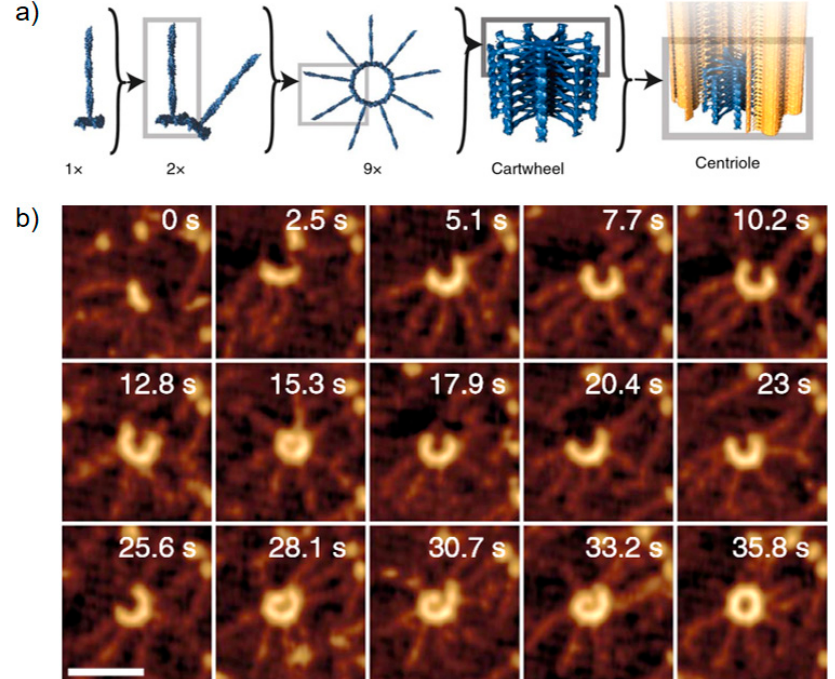
Figure 5. High-speed AFM imaging of biological systems using FEBID modified Si tips. ( a ) Formation process of cartwheels and centrioles by the assembly of CrSAS-6 homodimers, which arrange due to their coiled-coil/globular head domains. ( b ) High-speed, high-resolution imaging using FEBID tips, which make it possible to follow the formation of a cartwheel. Scale bar is 50 nm; Z range, 6.3 nm. Adapted and reprinted from Nievergelt et al., Nat. Nanotechnol. 2018 [65].